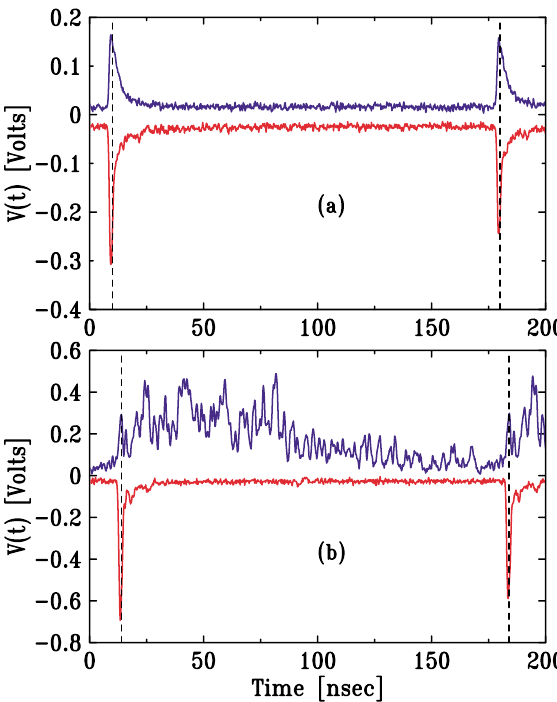
FIG. 3. (Color) Fast time structure for (a) B (positive, inverted . t signal) and C peaks and (b) A and C peaks.Vertical lines mark the revolution time for the single